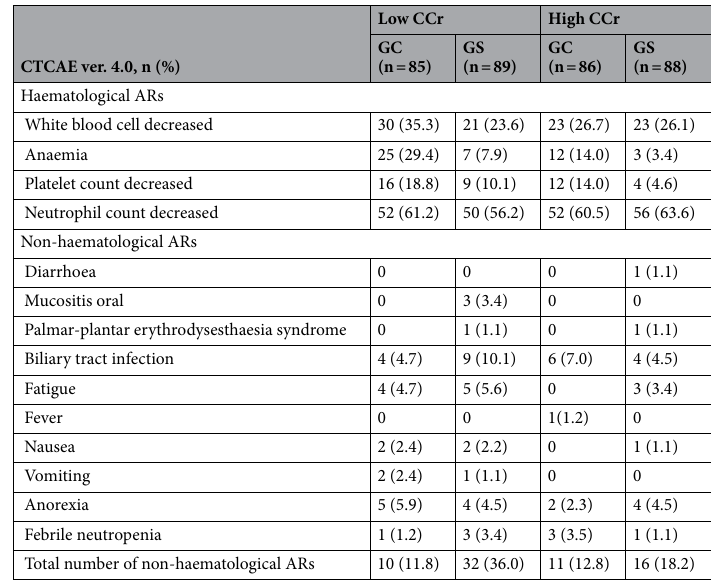
Table 2. Incidence of clinically important ≥ Grade 3 adverse reactions in the high and low CCr groups. AR adverse reaction, CCr creatinine clearance, CTCAE Common Terminology Criteria for Adverse Events, GC gemcitabine plus cisplatin, GS gemcitabine plus S-1.